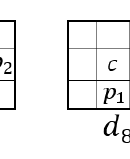
Figure 6. d 4 and d 8 metrics for the second step. Figure 7 illustrates the result of the two steps of the FDT.